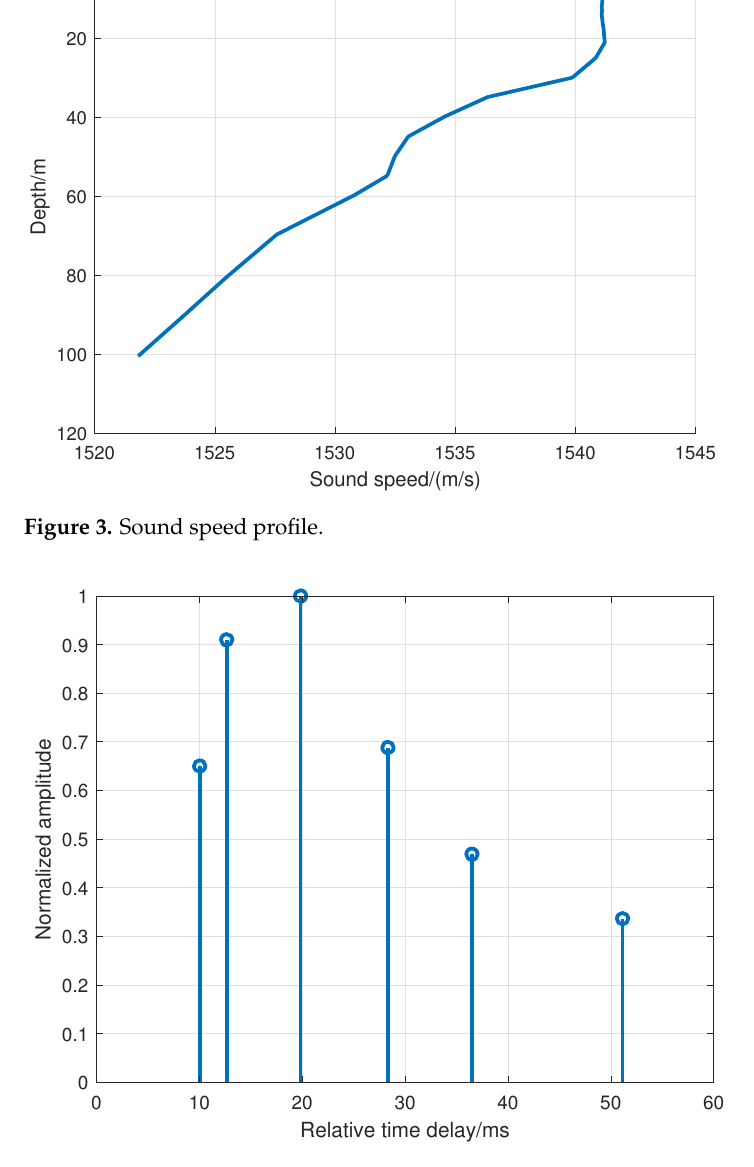
Figure 4. The simulated channel generated by Bellhop. Table 2. Acoustic channel